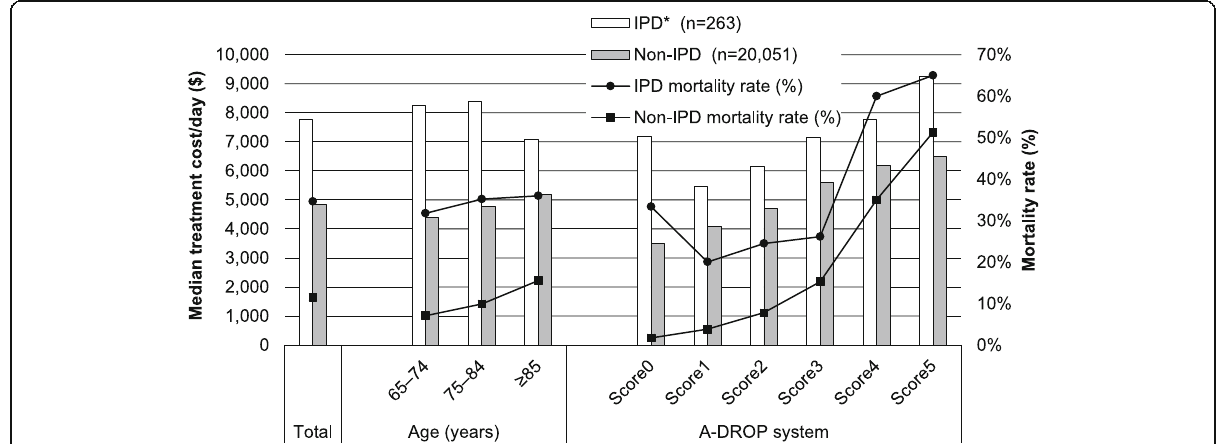
Fig. 3 The median all-cause treatment costs of community-acquired pneumonia episodes with or without invasive pneumococcal disease episodes. *IPD: invasive pneumococcal